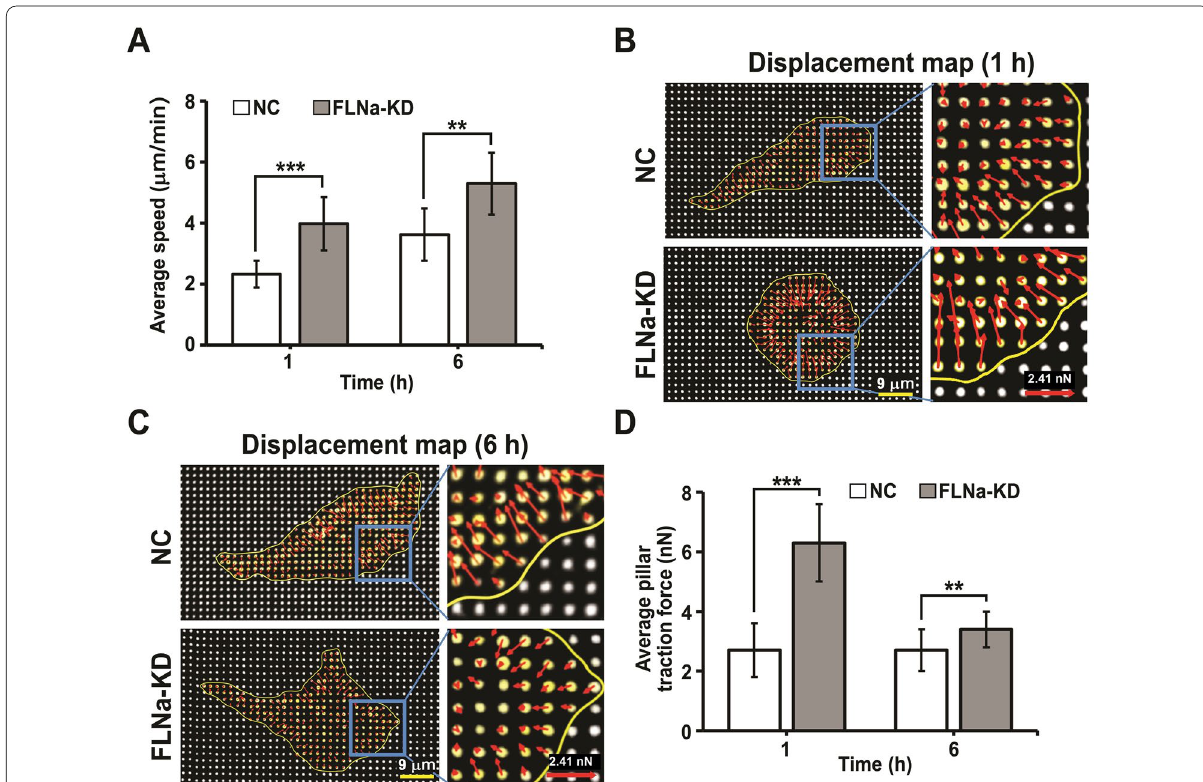
Fig. 3 Motility and TFs of NC and FLNa-KD cells on fibronectin-coated pillars ( A ) Average speed of cells (n 10 cells) at 1 and 6 h of incubation on = the pillars. The representative deflection maps ( B , C ) of the NC and FLNa-KD cells on pillars at 1 h ( B ) and 6 h ( C ). The yellow line is the approximate boundary of the cells. The red arrow indicates the deflection magnitude and direction of each pillar. ( D ) Average TFs of the cells at 1 and 6 h. Number of samples, (n 40 cells). Error bar represents the mean SD; ** P < 0.01, *** P < 0.001; Student’s = ±